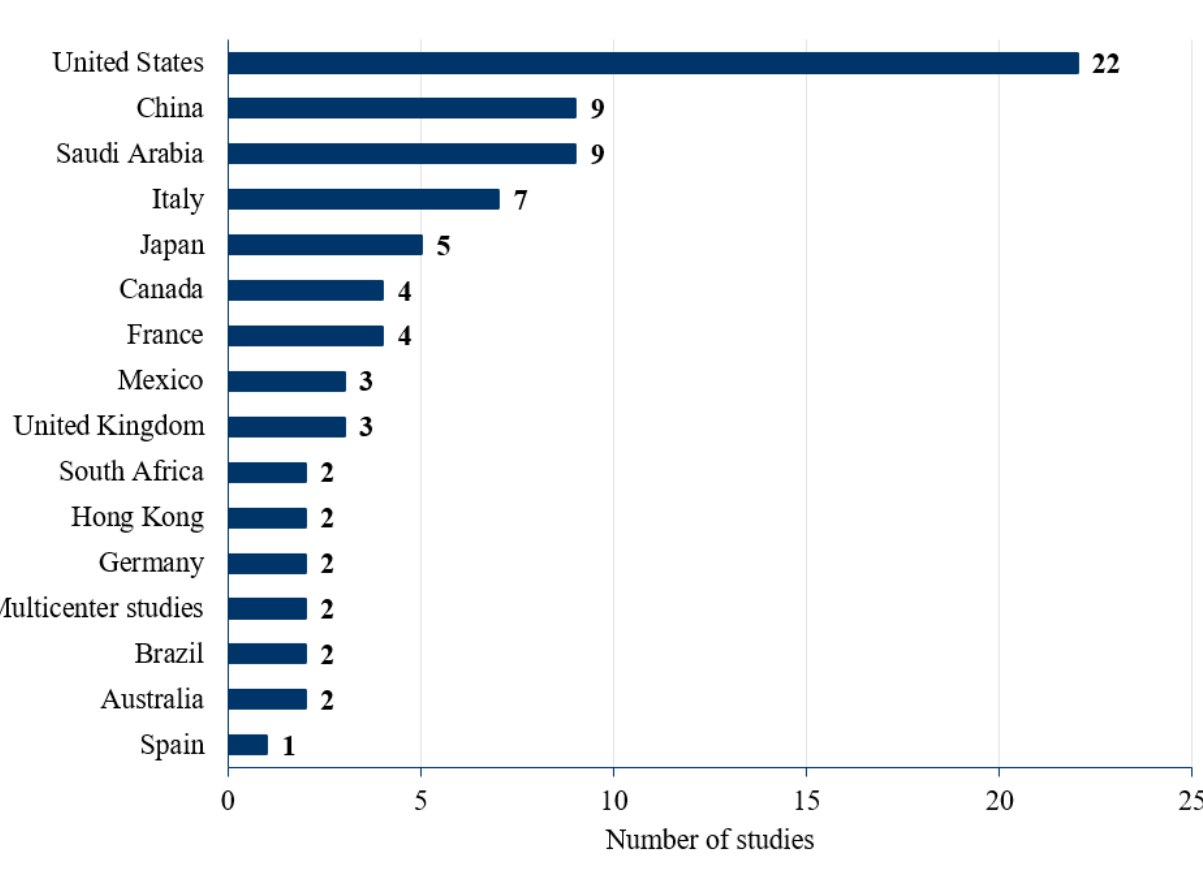
Figure 2. Studies reporting the barriers to influenza vaccination by country.